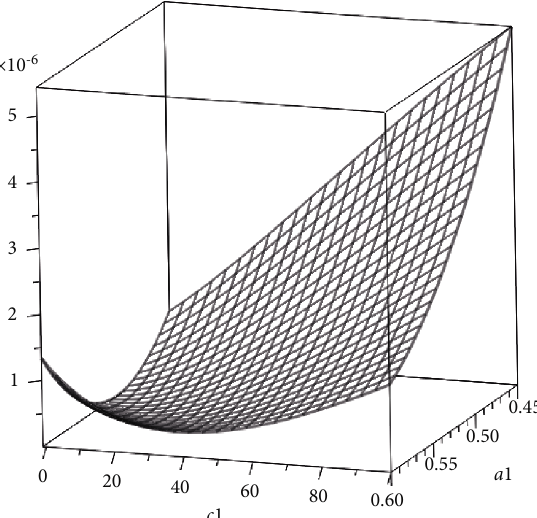
Figure 7: The graph of the data ( a and − 1 ≤ c